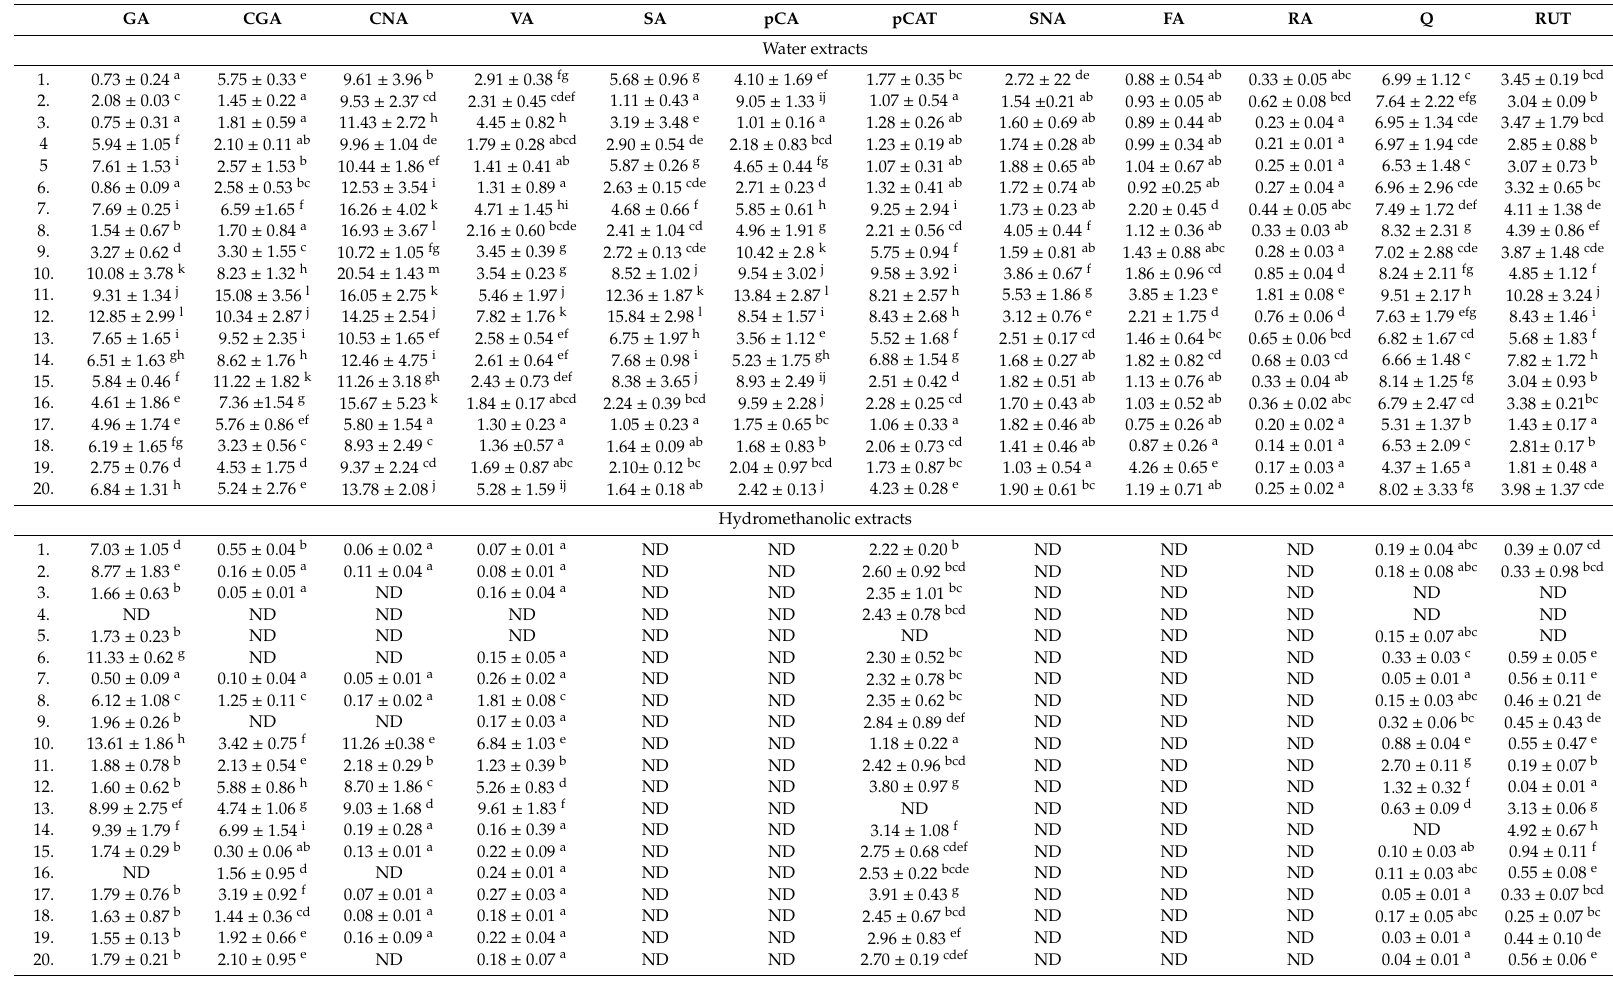
Table 2. The content of phenolic acids and flavonoids ( µ g / g DW) in the samples of Rosa canina